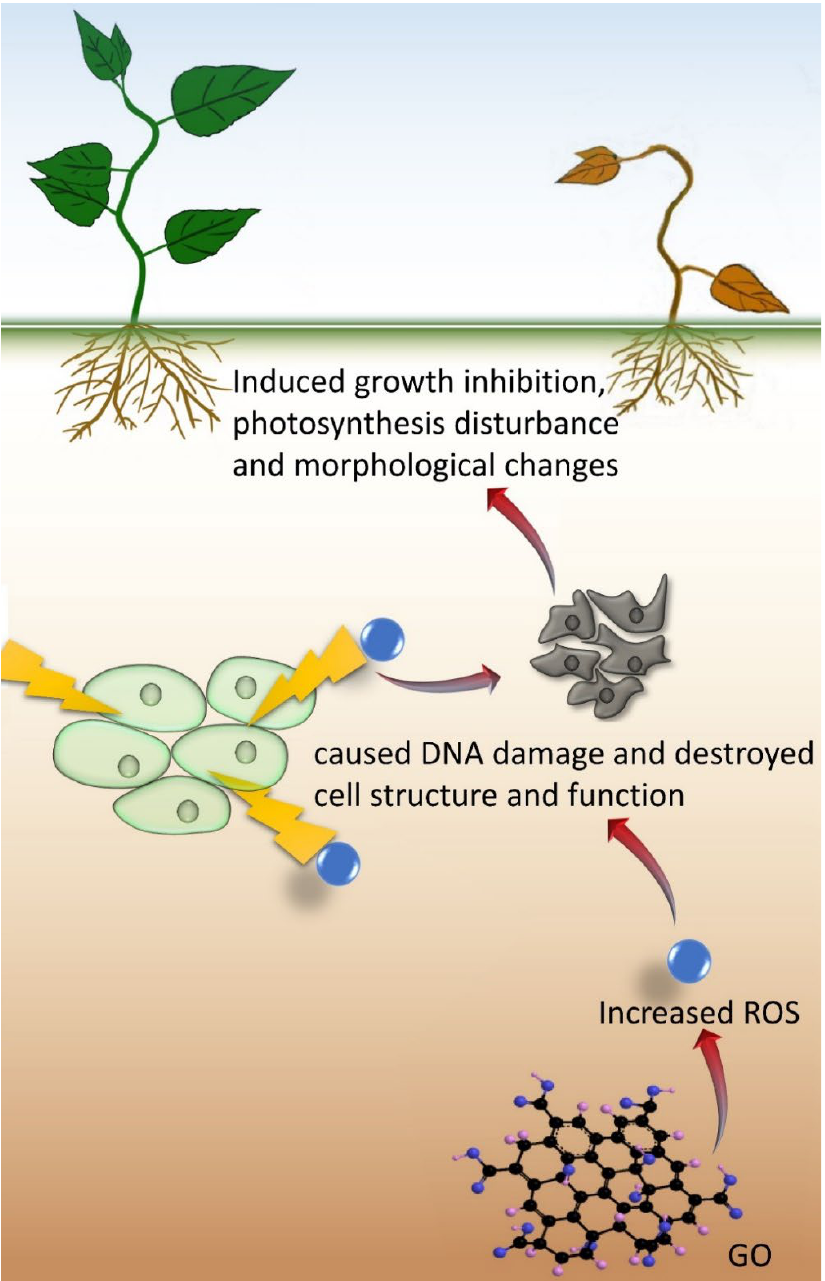
Figure 4. The mechanism of GO in inhibiting plant growth.